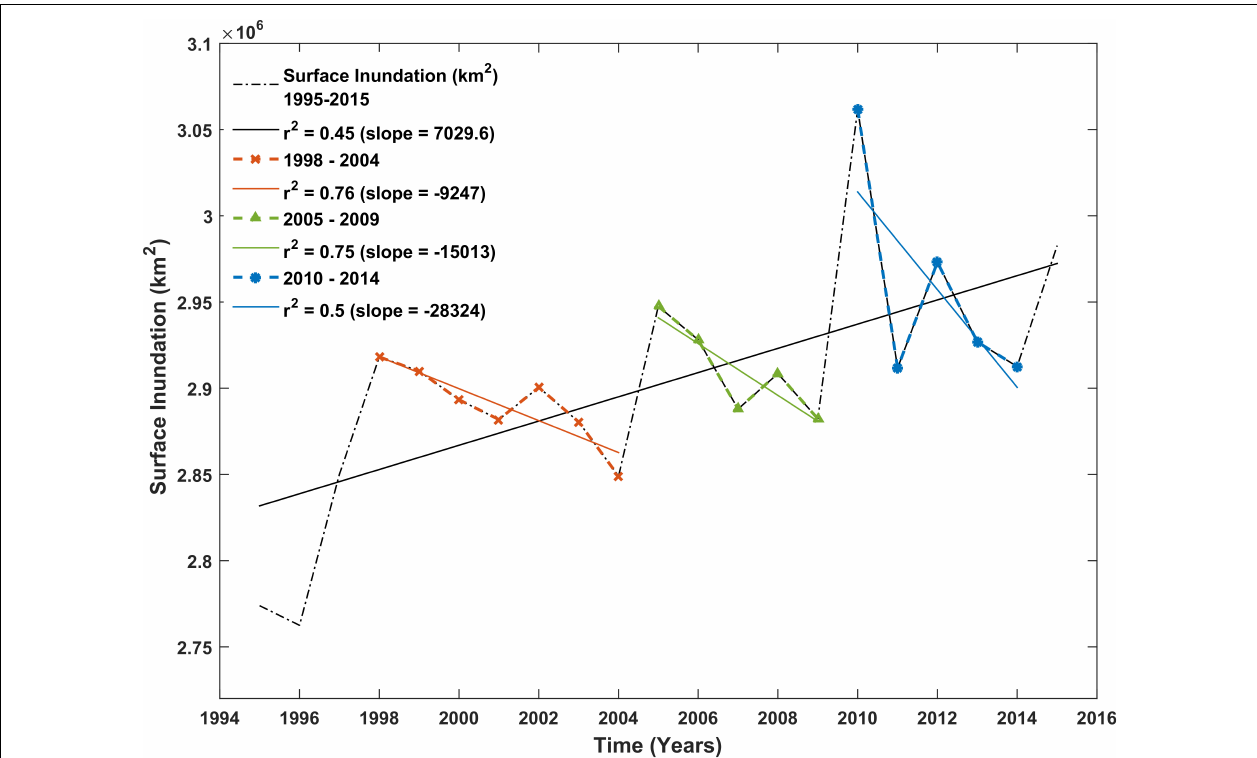
FIGURE 2 | Temporal trends in global surface inundation extent (km 2 ) variability from 1995 to 2015 (black). Three periods of declining trend were identified through 1998–2004 (orange), 2005–2009 (green), and 2010–2015 (blue). The open water bodies like lakes and reservoirs and wetland classes of swamps and coastal wetlands have shown the most significant increase in inundation